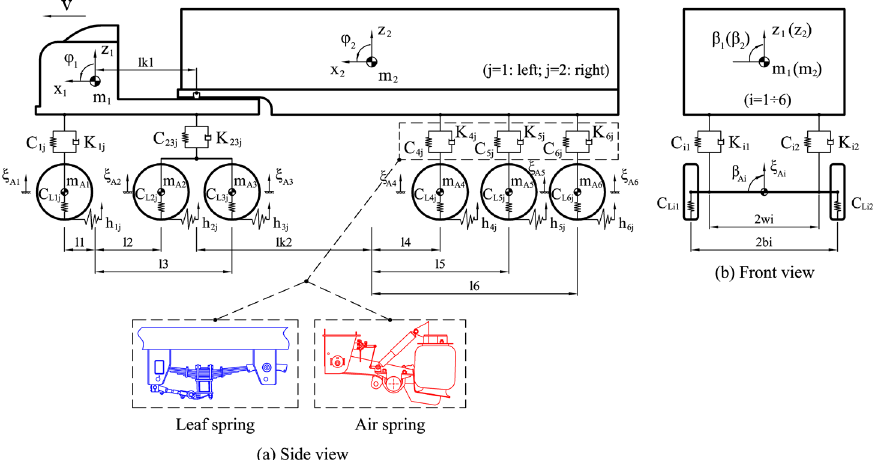
Figure 1. Full vertical dynamic model of a tractor semi-trailer using two types of suspension systems: ( a ) Side view, ( b ) Front view .